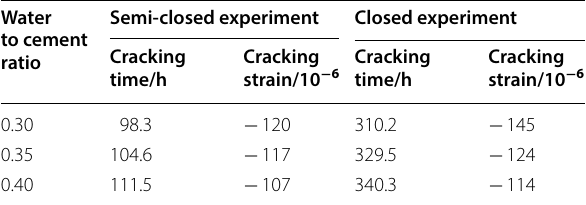
indicators of cement mortar with different water-cement